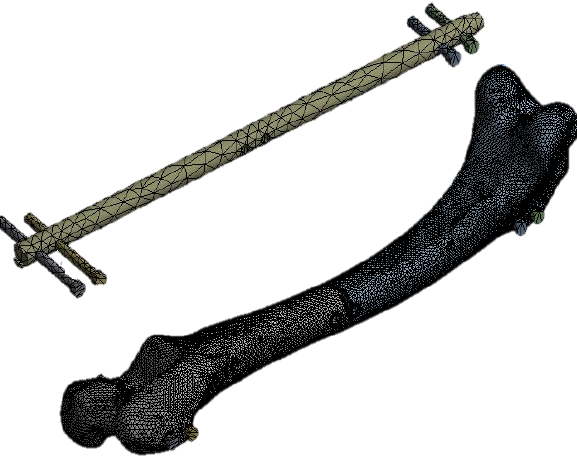
Table 5. Six locking screws: the multilevel factorial design of relevant factors and their levels. (Number of levels: 2, 3, and 3.).